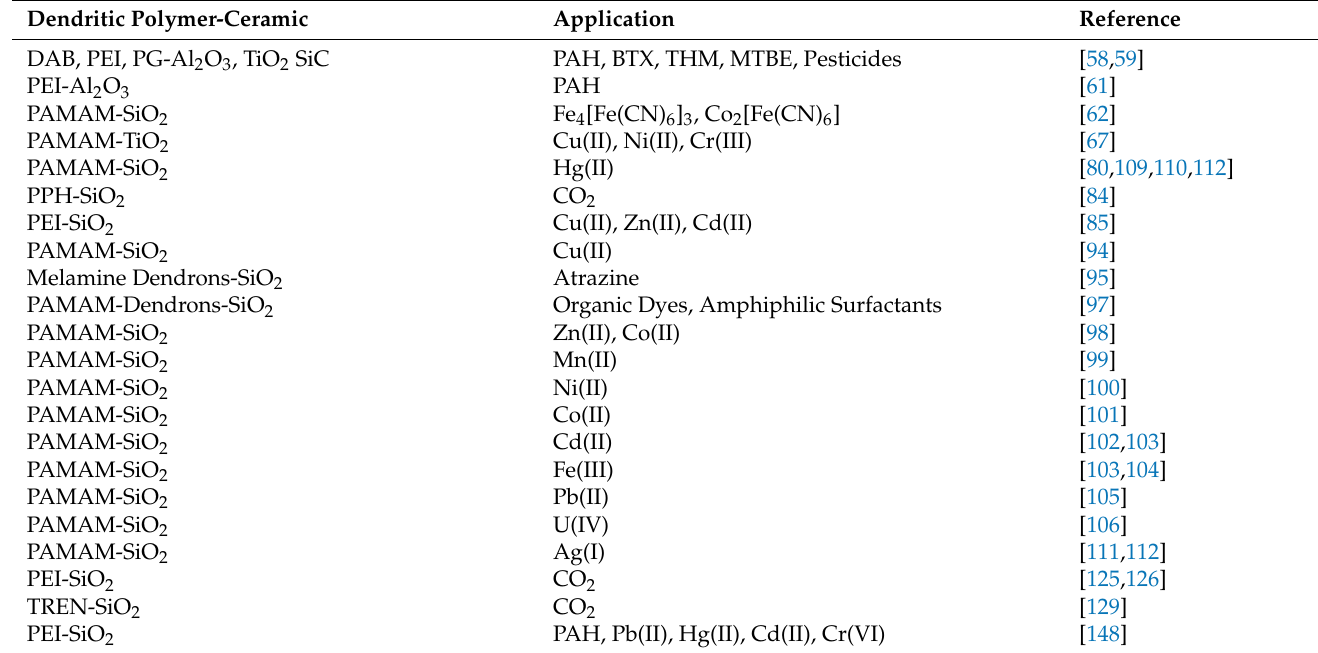
Table 3. Adsorption properties of ceramics/dendritic polymer composites.